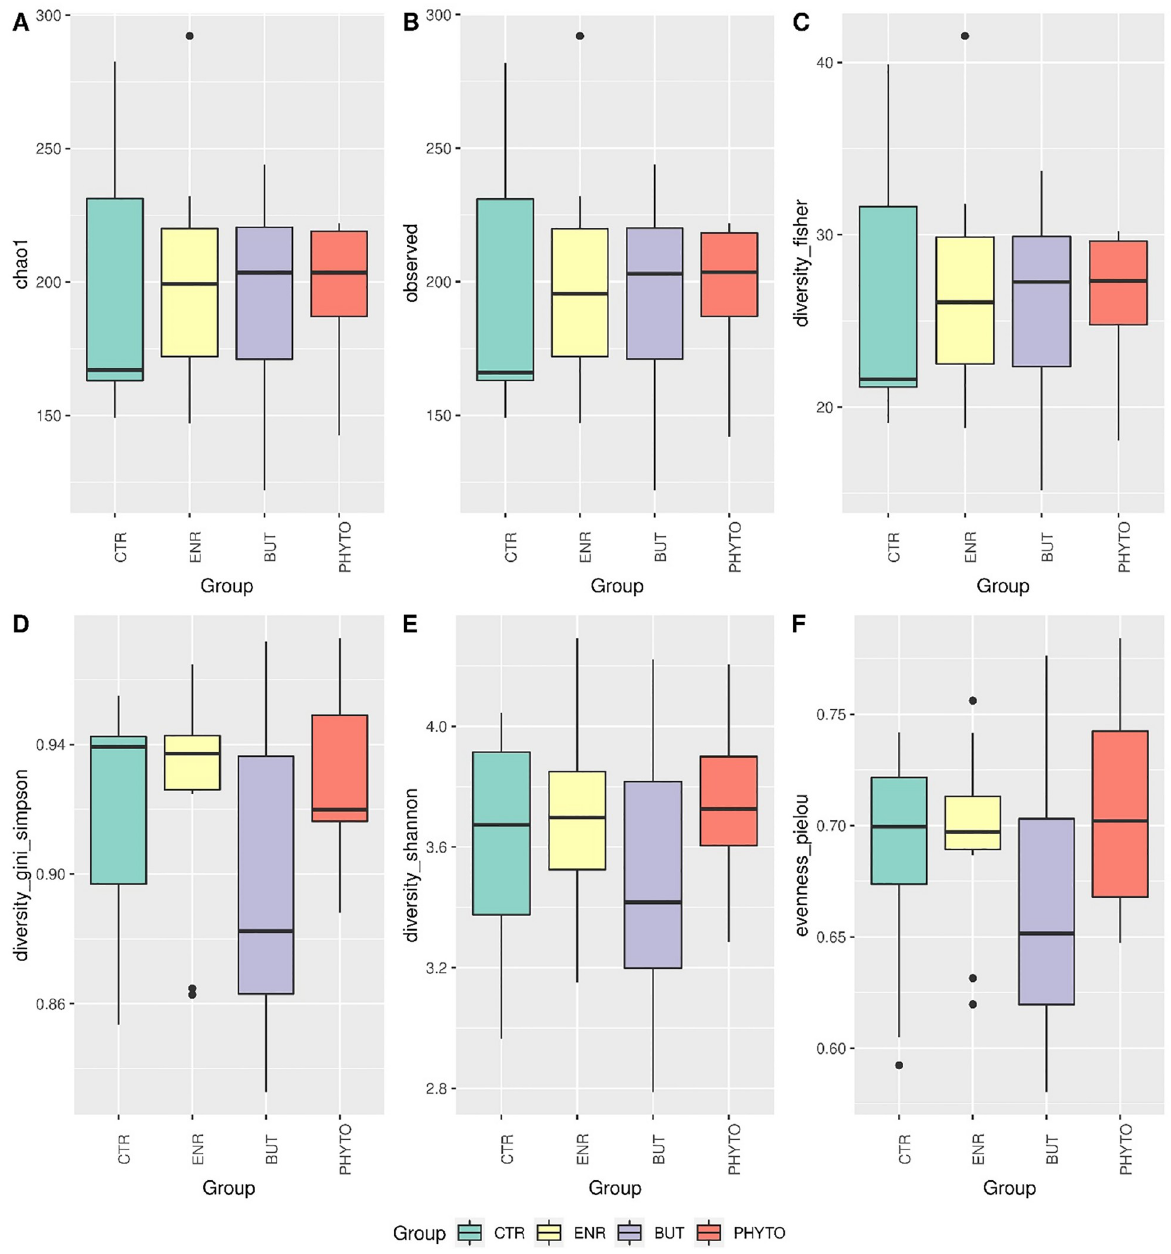
Fig 2. Alpha-diversity estimated by the parameters Chao1 (A), observed OTUs (B), Fisher (C), Simpson index (D), Shannon entropy (E), and Evenness Pielou (F). Statistical comparison between groups was performed using Wilcoxon’s nonparametric test. Statistical results less than 0.05 were accepted as statistically